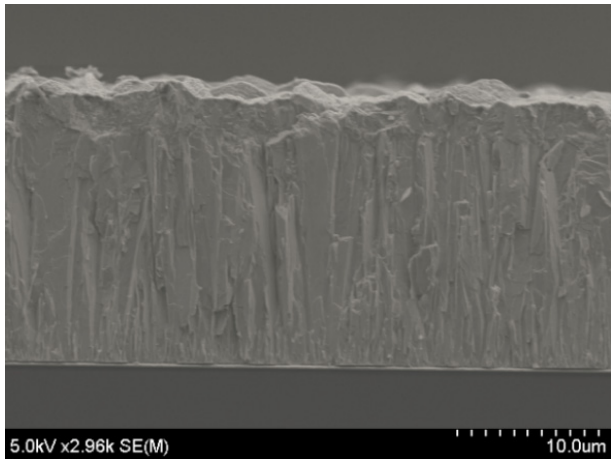
Figure 11. Cross-section structure of the film grown by pulsed deposition.